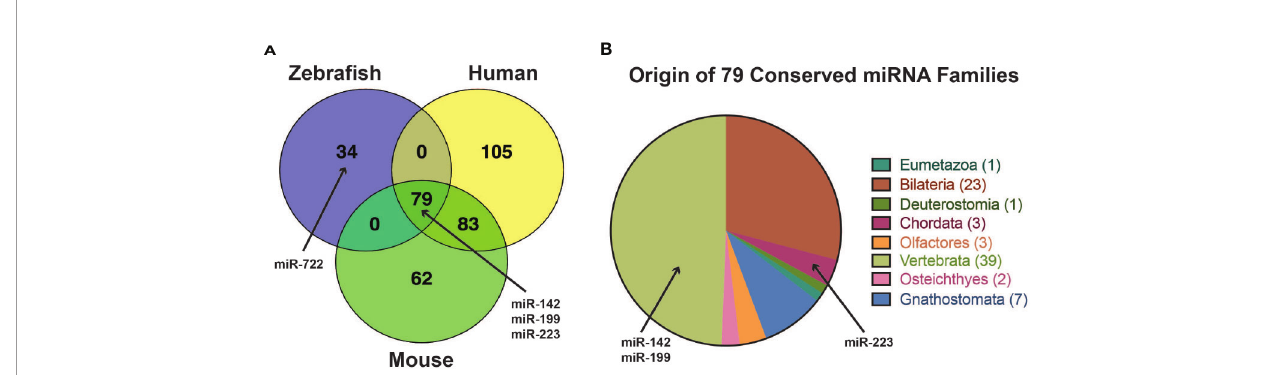
FIGURE 3 | Overlap among miRNA families in zebra fi sh, mouse, and human genomes. (A) 79 miRNA families are conserved among zebra fi sh, mouse and human genomes, including miR-142, miR-199 and miR-223. 34 miRNA families are found in the zebra fi sh, but not in the mouse or human genome. One of the 34 miRNA families is miR-722 which was shown to regulate zebra fi sh neutrophil migration. 62 miRNA families are found in the mouse, but not in the zebra fi sh or human genome. 105 miRNA families are found in the human genome, but not in the zebra fi sh or mouse genome. 83 miRNA families are conserved between the mouse and human genomes that are not found in the zebra fi sh genome. (B) The origin of the 79 conserved miRNA families are labeled by the last common ancestor for Eumetazoa, Bilateria, Deuterostomia, Chordata, Olfactores, Vertebrata, Osteichthyes, and Gnathostomata with the number of families shown in parentheses. Two of the 79 miRNAs are miR-199 and miR-223 that have roles in neutrophil function. The node of origin for miR-142 and miR-199 is Vertebrata, and Gnathostomata for